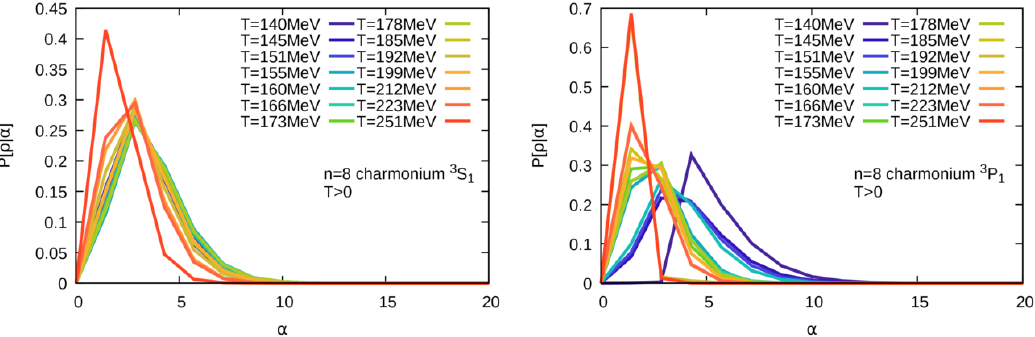
Figure 34 . Representative examples of the probability distribution over the hyperparameter (cid:11) used in the self consistent determination of the most probable spectrum at (cid:12)nite temperatures. We show here charmonium results, the left panel contains the S-wave results, the right panel the P-wave channel.